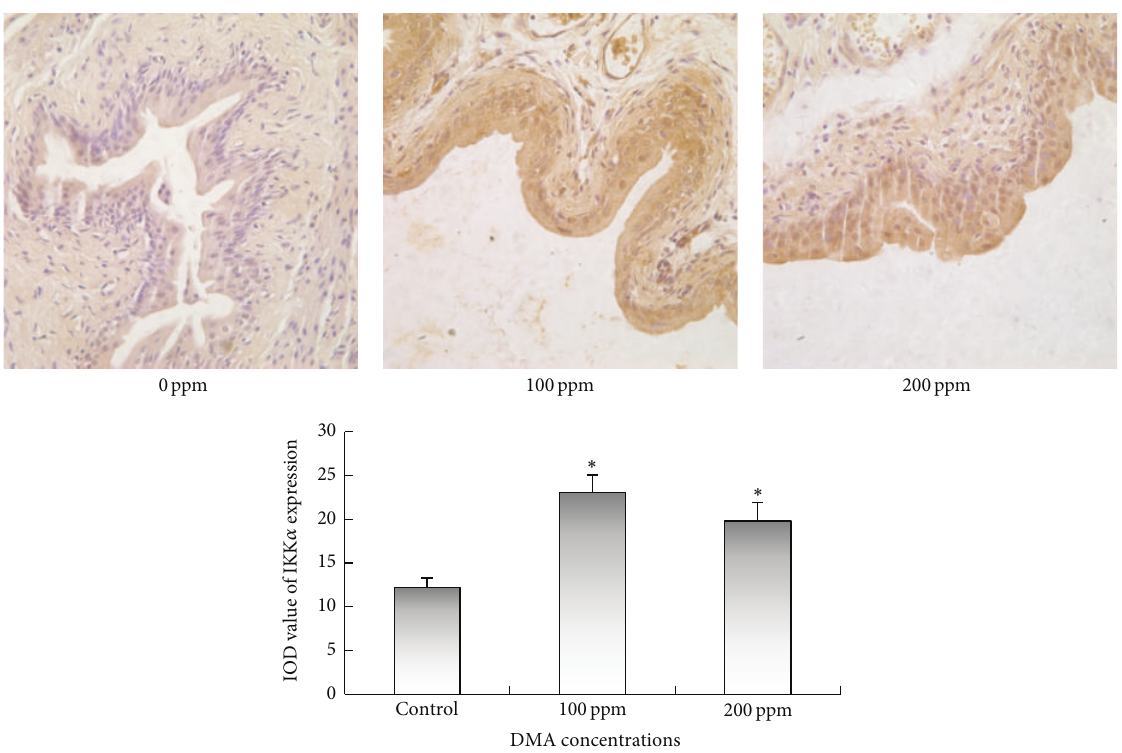
Figure 3: IKK 𝛼 immunohistochemical staining of bladder epithelium in DMA V treated rats. IKK 𝛼 expressions were presented in brown in cytoplasm. The panel was a graphical representation of the immunointensities of IKK 𝛼 . Bars were presented as mean ± SD. ∗ 𝑝 < 0.05 compared to the control